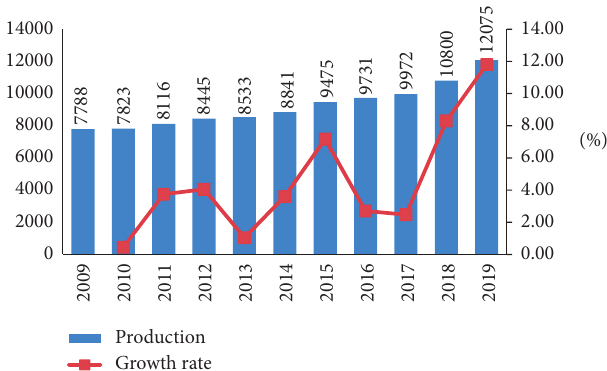
Figure 1: 2009–2019 annual production of kitchen waste in